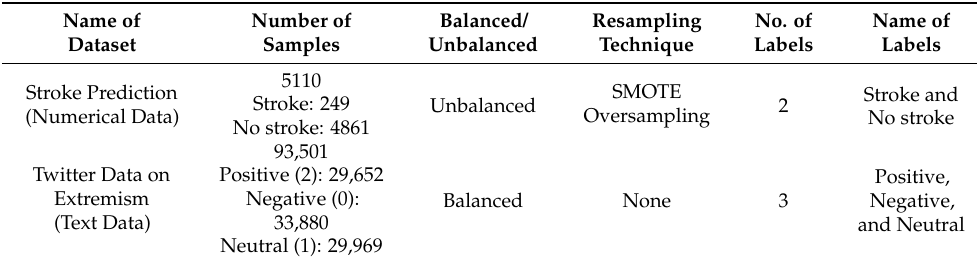
Table 2. Dataset details shown with different